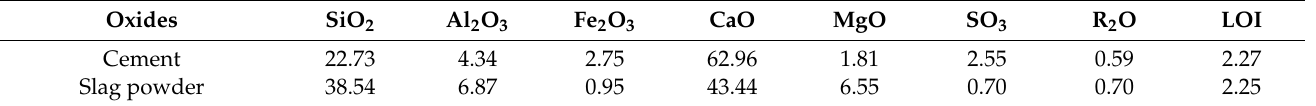
Table 1. The chemical compositions of cement and slag powder